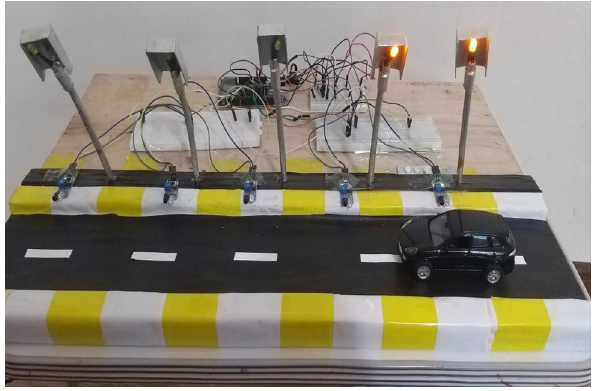
Figure 1: Switching ON the light column nos. 1 and 2, while 3, 4, and 5 are